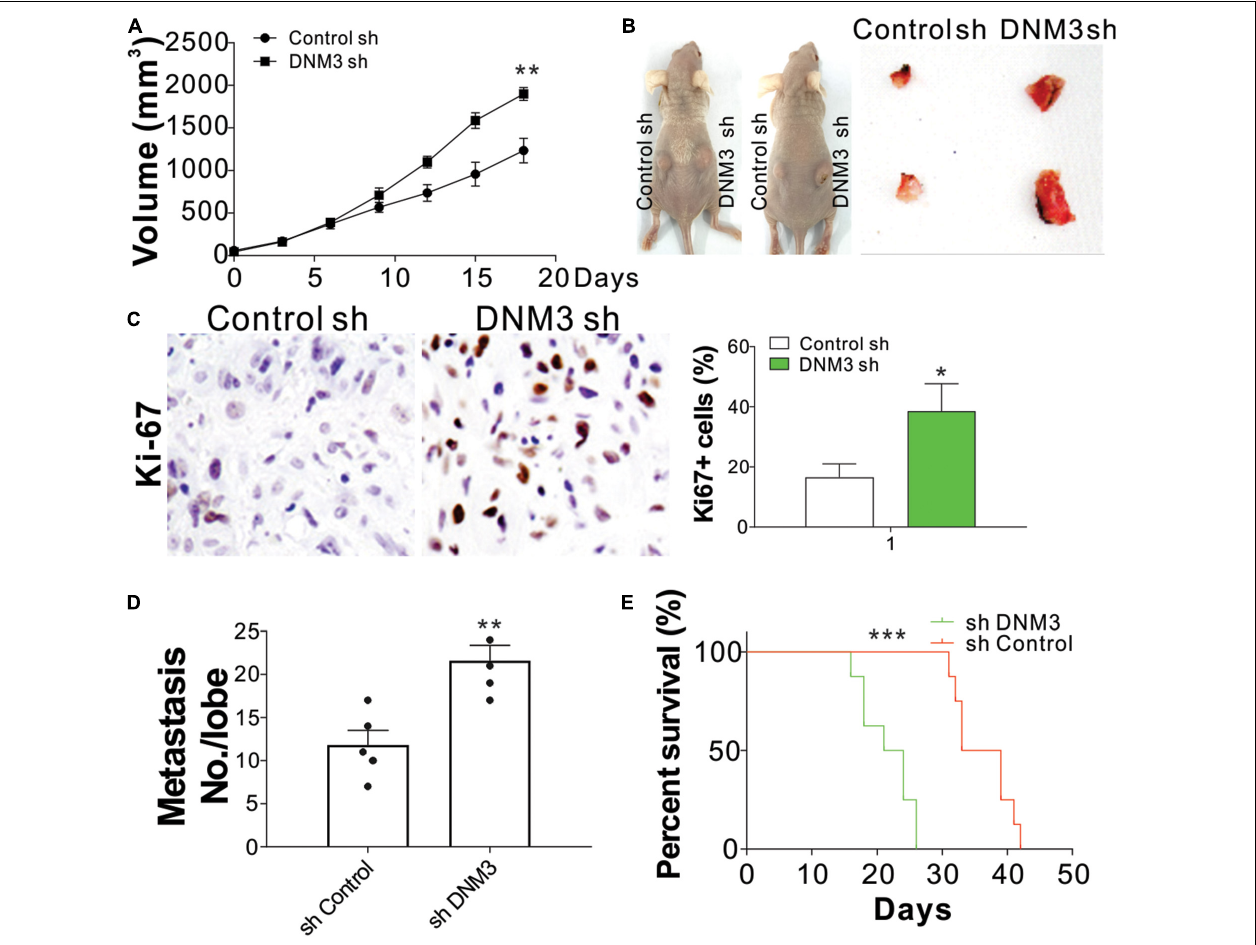
FIGURE 3 | Reduced DNM3 expression promotes lung cancer tumor growth and metastasis in vivo . (A) Tumor growth in nude mice xenografted with H1299 cells with or without stable DNM3 knockdown ( n = 5 for each group). (B) Representative picture of xenografted tumors. (C) Ki-67 staining of tumors in each group. (D) Metastatic tumors in the lung tissue of nude mice ( n = 5 for each group) injected through the tail vein with H1299 cells with or without stable DNM3 knockdown. (E) Survival of nude mice ( n = 8 for each group) injected through the tail vein with H1299 cells with or without stable DNM3 knockdown. Experiment in C was repeated 3 times. * p < 0.05; ** p < 0.01; *** p <